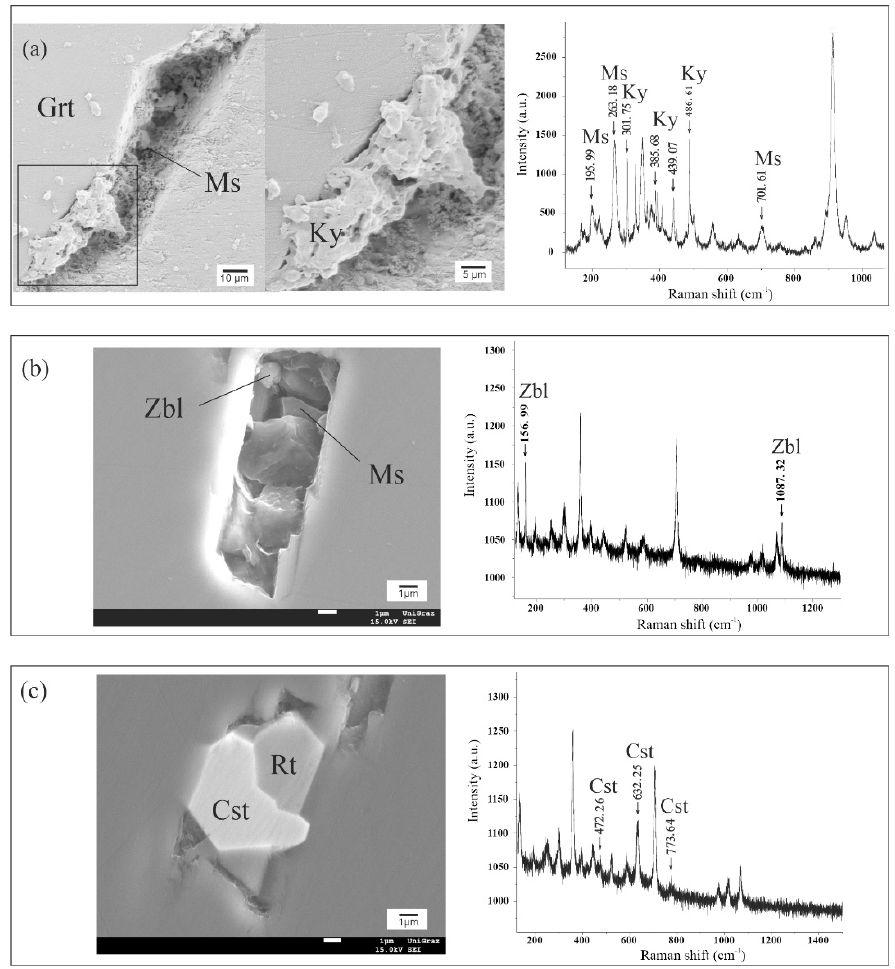
Figure 5. Electron microprobe images of subsurface cavities from ( a ) garnet host (sample WB01) and ( b , c ) spodumene host (sample W08). Representative Raman spectra are shown on the right side.